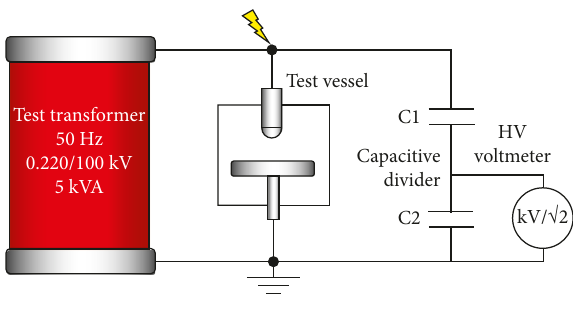
Figure 1: Test setup.